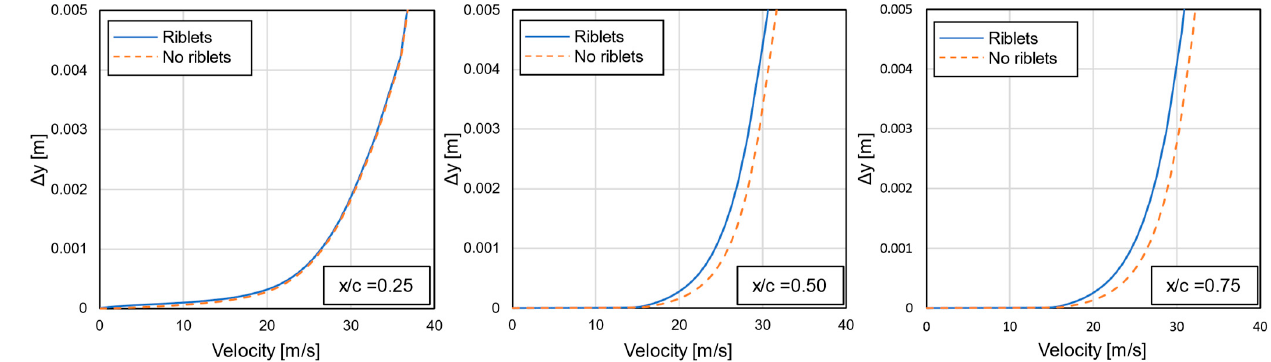
Figure 16. Velocity profiles on the fuselage plane at selected positions, at design conditions.